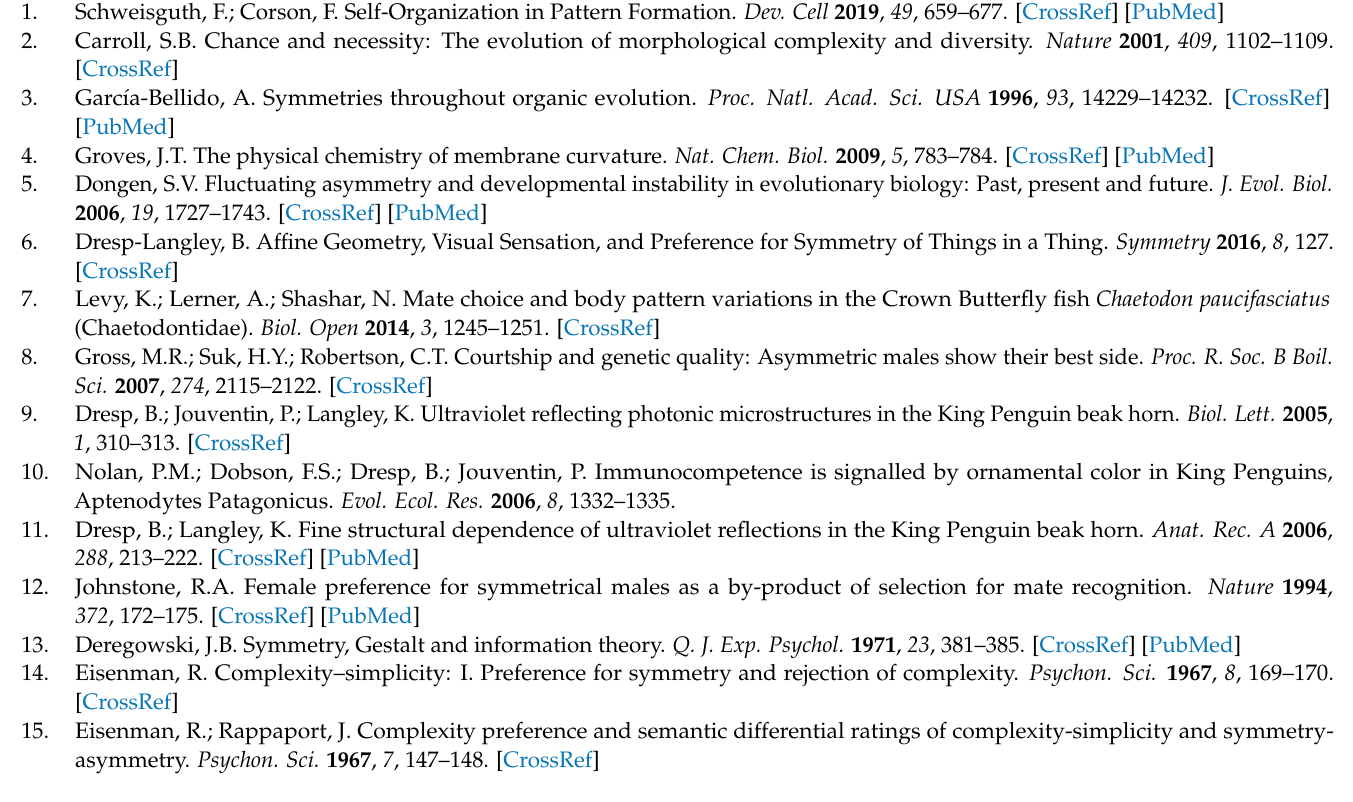
Figure S2: Python code relative to image presentation control, Figure S3: Python code relative to experimental session control, Table S1: Excel file with the individual RT data subjected to two-way anova, Table S2: 2-Way ANOVA output